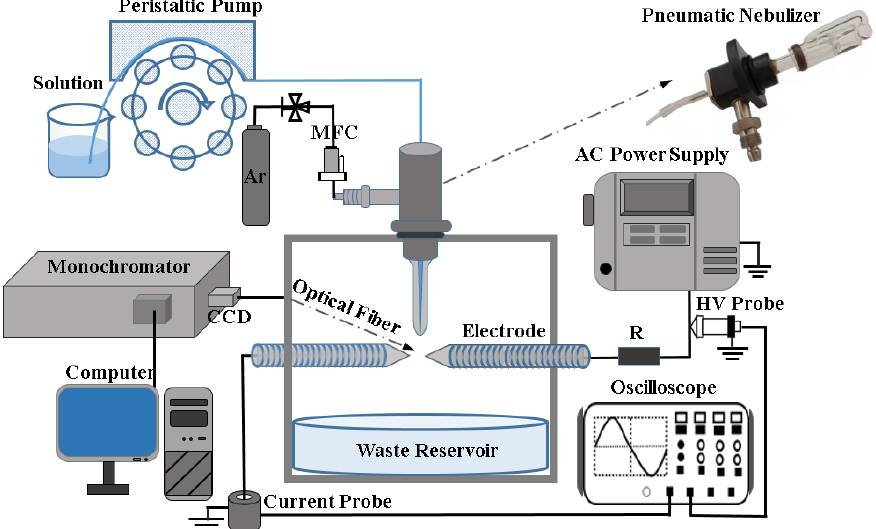
Figure 1. The experiment setup of nebulized discharge plasma-AES for detecting trace Cu.